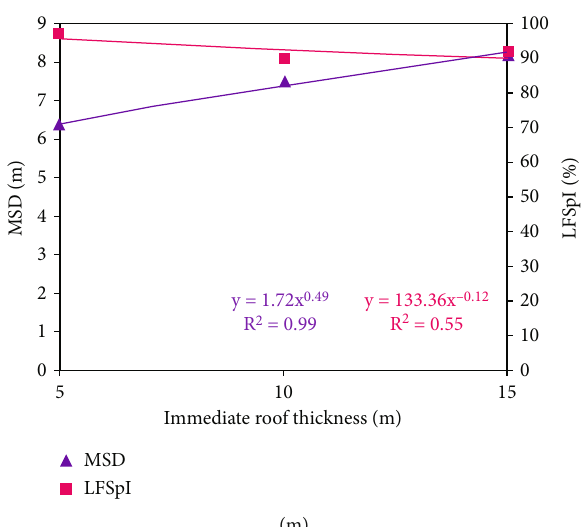
S E S S E S v , (b) Hoe, (c) cc , (d) c , (e) tc , (f) cir , (g) i , (h) tir ,